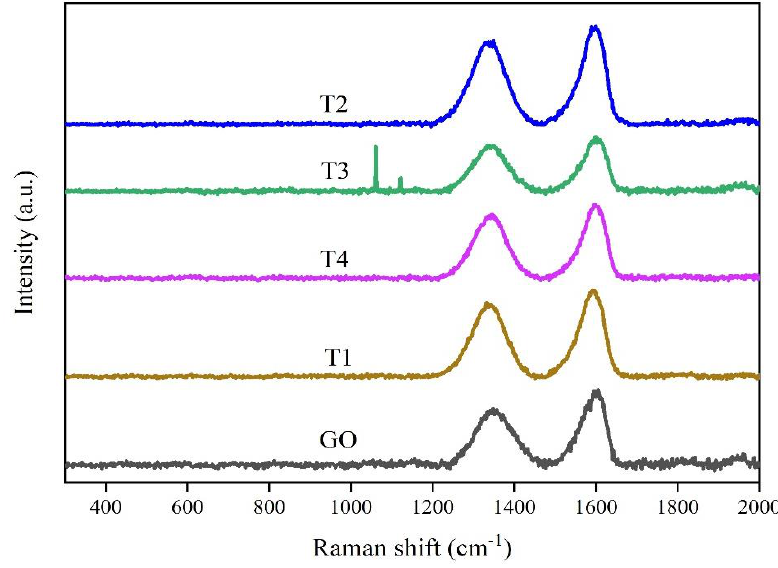
Figure 5. Raman patterns of GO and ZrO 2 /RGO composites T1–T4. Figure 6 shows the UV-Vis absorption peak position of the sample. The absorption peak of GO was at 228.96 nm, which might be mainly derived from the π - π * transition of C-C and C=C in sp 2 hybridization [30]. For ZrO 2 /RGO nanocomposites, with the increase of ZrO 2 concentration, the absorption peaks were located at 262.79 nm, 264.16 nm, 266.07 nm, and 275.15 nm, respectively. The absorption peak underwent red shift. The energy gap (E g ) of ZrO 2 was estimated to be 5.47 eV, and the band gaps of ZrO 2 /RGO composites T1-T4 were calculated from UV absorption peaks as 4.72 eV, 4.69 eV, 4.66 eV and 4.51 eV, respectively. The red shift of the absorption peak and the reduction of the band gap pro- vided the basis for the covalent bond between graphene and ZrO 2 . The high refractive index of ZrO 2 and the high electron mobility of graphene, as well as the charge transfer between graphene and ZrO 2 , made the band gap of the composite become smaller. Figure 6. UV-Vis absorption spectra of ZrO 2 and the ZrO 2 /RGO composites T1–T4.